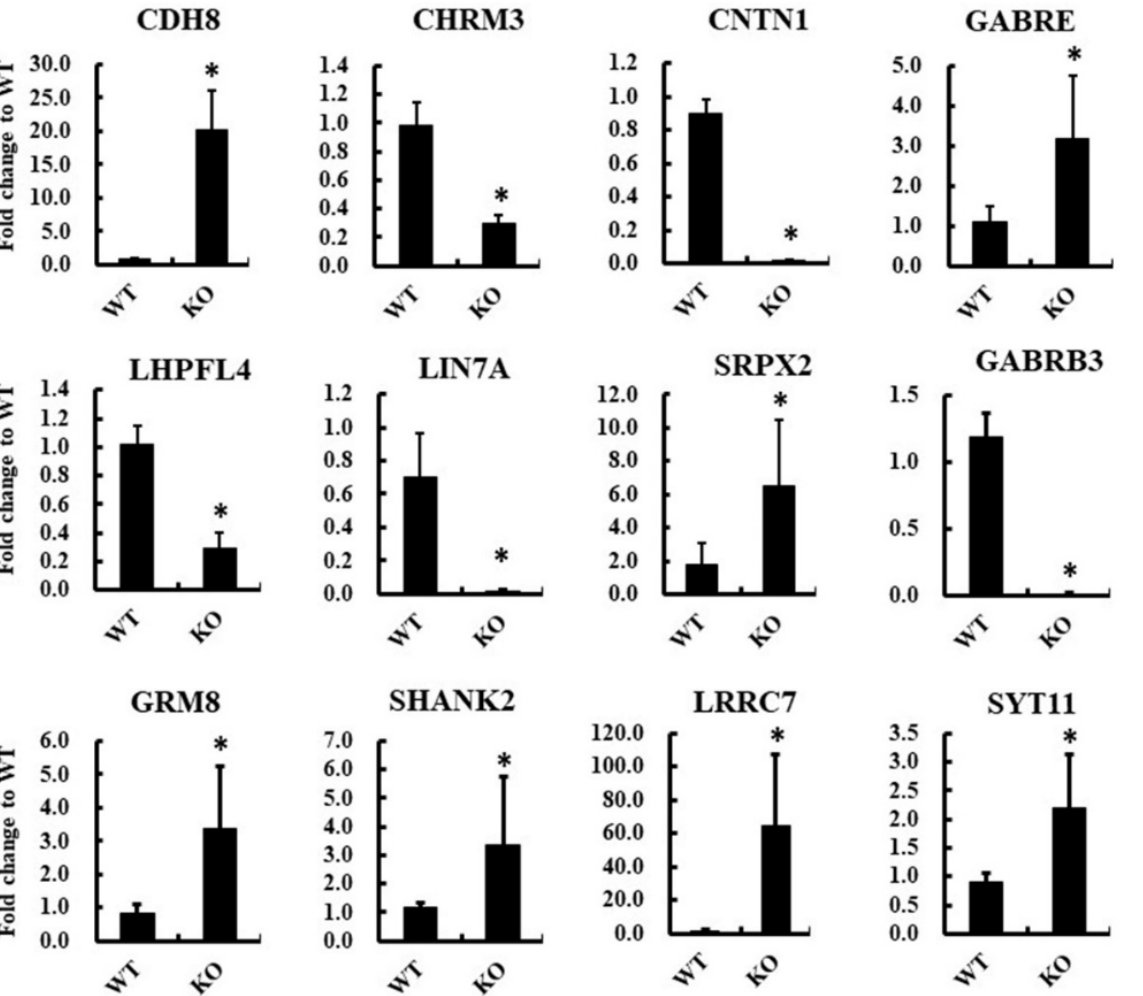
Figure 3. RT ‐ qPCR assay results showing the expression of 12 synaptic membrane ‐ associated genes ( CDH8 , CHRM3 , CNTN1 , GABRE , LHFPL4 , LIN7A , SRPX2 , GABRB3 , GRM8 , SHANK2 , LRRC7 , and SYT11 ) in ARC ‐ KO and ARC ‐ WT HEK293 cells. GAPDH was used as an endogenous gene for normalization. Data are expressed as fold changes relative to ARC ‐ WT ± SD (* p < 0.05; n = 6). Table 1. Top five GO terms enriched in ARC ‐ KO ‐ related DEGs.